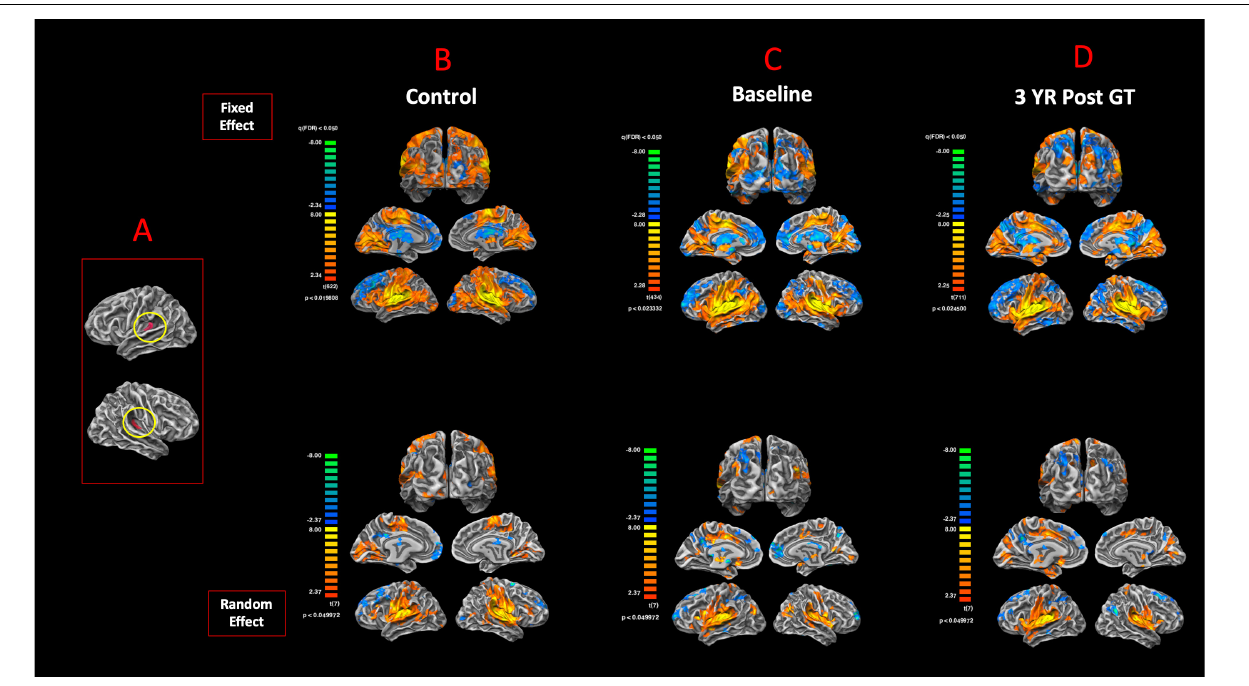
FIGURE 6 | Functional connectivity of the primary auditory areas. Anatomical locations for both the left and right Brodmann primary auditory areas (BA41) (A) . The functional connectivity group results for FX and RFX analysis are presented for (B) sighted controls, (C) RPE65 patients at baseline, and (D) RPE65 patients 3 years post–gene therapy. All fixed-effects group analyses were performed at FDR corrected p < 0.02 ( q < 0.05), with an extent threshold of > 100 mm 2 , and all RFX analyses were performed at an uncorrected p < 0.05 with an extent threshold > 100 mm 2 . Sighted controls showed significant bilateral functional connectivity between auditory, sensorimotor, frontal, and visual cortices. At baseline, compared to controls and post–gene therapy time point, RPE65 patients expressed similar, yet attenuated connectivity patterns particularly along the bilateral visual cortices. Three years after receiving their gene therapy, RPE65 patients’ connectivity of the primary auditory areas to the visual cortex significantly increased, yet remained attenuated as compared to the observed connectivity of the sighted